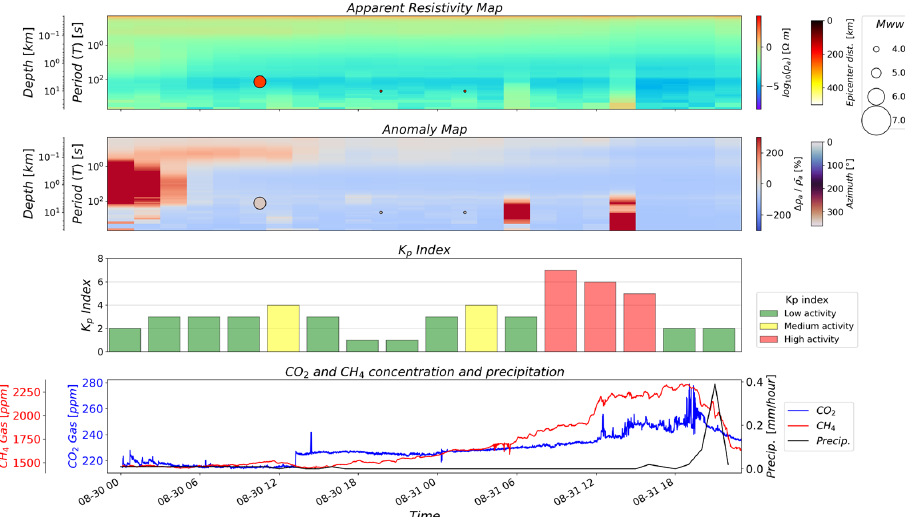
Figure 4. Time window after starting large anomaly (A) and presented in Figure 3, which shows a shallowing of the ρ a anomalies (suggested by yellow arrows in the second panel) that coincide with the beginning of more significant emissions of CH 4 and CO 2 in the Marambio Station. These gasses are typically stored in the permafrost near the measurement instrument [13], but regional pore pressure perturbances promote their trigger emission. Deeper and strong anomalies in the 1D– ρ a structure seem to be influenced by solar activity, as shown the K p index distribution. Precipitation data are taken from https://power.larc.nasa.gov/data--access--viewer/ (accessed on 15 December